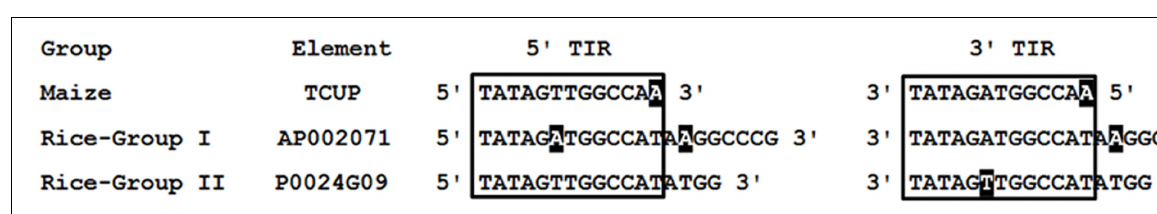
TCUP sixth position are in bold.The core 12bp of similarity is boxed. Sequences not matching the consensus are shaded in